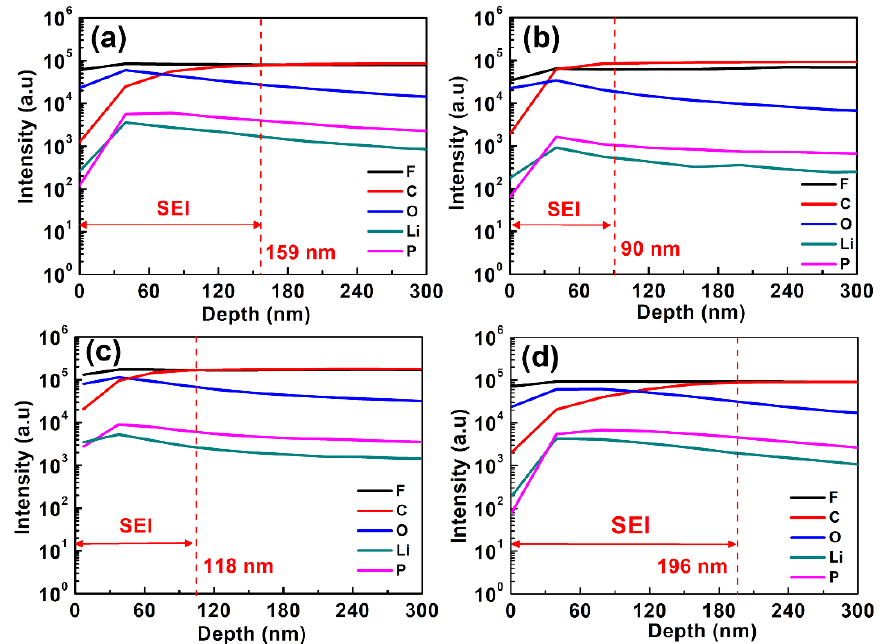
Figure 8. SIMS depth profile of the MCMB electrode with additive-free electrolyte and different concentrations of PMA added electrolyte at 55 ◦ C. ( a ) additive-free electrolyte, ( b ) 0.5 wt.% ( c ) 1.0 wt.% and ( d ) 2.0 wt.% of PMA additive .